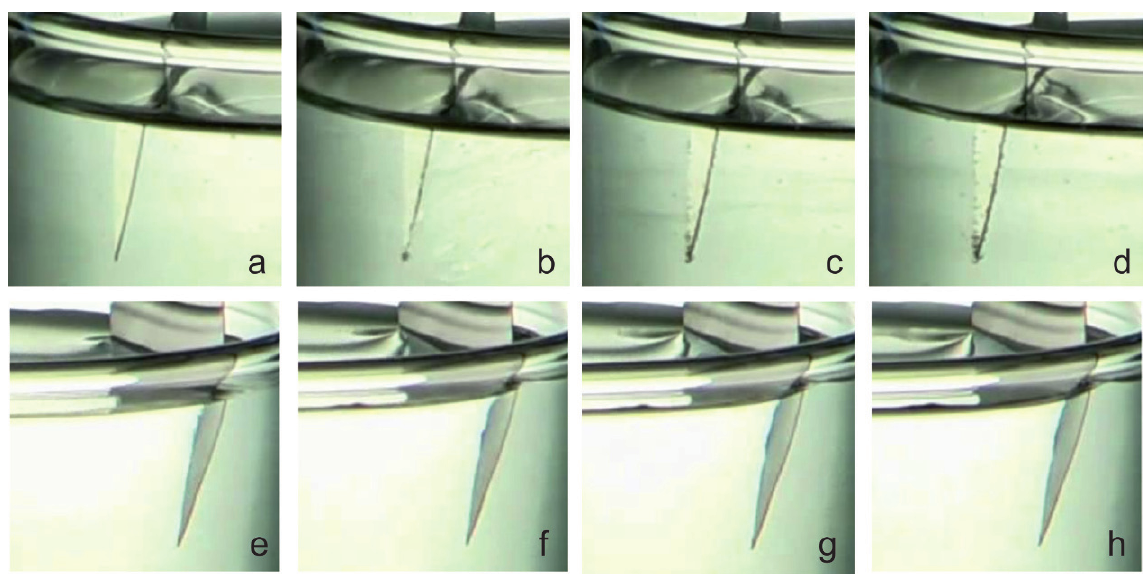
Figure 13. Gas formation over time at the anode (a-d) during experiment 5f (531 mM phenol in both beakers) in comparison to the cathode where no gas formation could be observed (e-h). The pictures were taken after 34 (a,e), 94 (b,f), 214 (c,g) and 274 s (d,h), respectively.